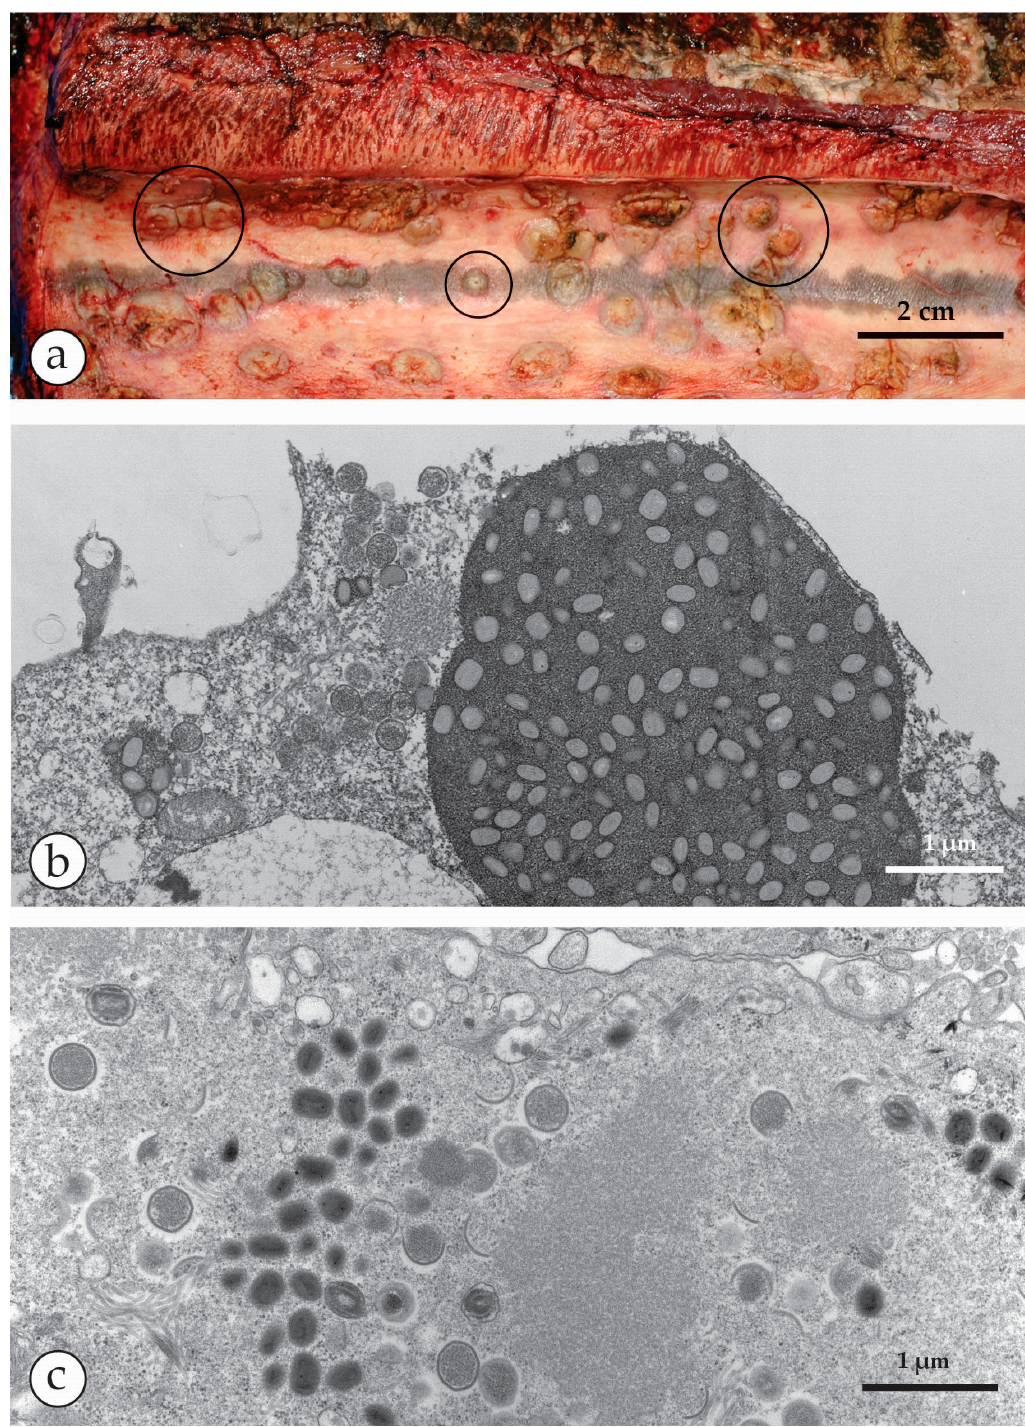
Figure 4. Peculiarities of CPXV infections: wide host range and specific inclusion bodies. ( a ) Lesions on the inner surface of a trunk of a deceased elephant, sliced longitudinally showing multiple ulcerous lesions on the mucous membranes [34]. Image courtesy Dr. Gudrun Wibbelt, Berlin. ( b ) After inoculation from the elephant´s ulcers in diagnostic cell cultures, well-circumscribed inclusion bodies developed consisting of a moderately dense matrix that included numerous mature virions. These are type A eosinophilic inclusions as seen in light microscopical histology and called Downie or Marchal bodies. They are typical of CPXV but found with a few other poxvirus genera [35]. ( c ) OPV are assembled in large cytoplasmic “factories” but these are basophilic (type B inclusions or Guarnieri bodies) in light microcopy and less well circumscribed.